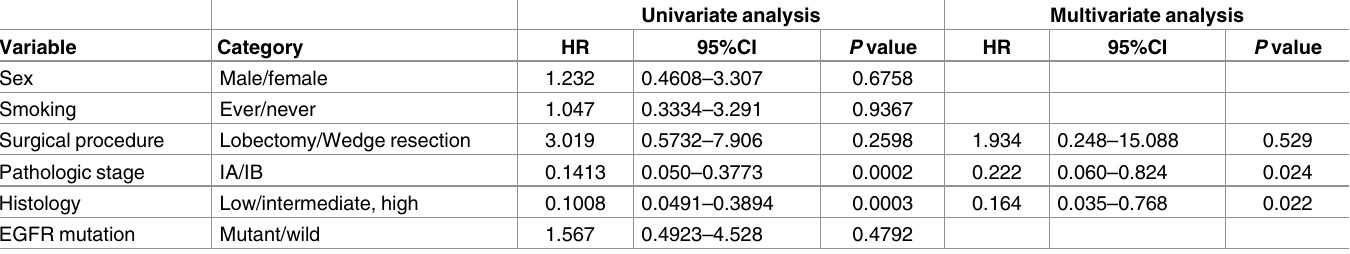
Table 4. Cox proportional hazards model for analysis of overall